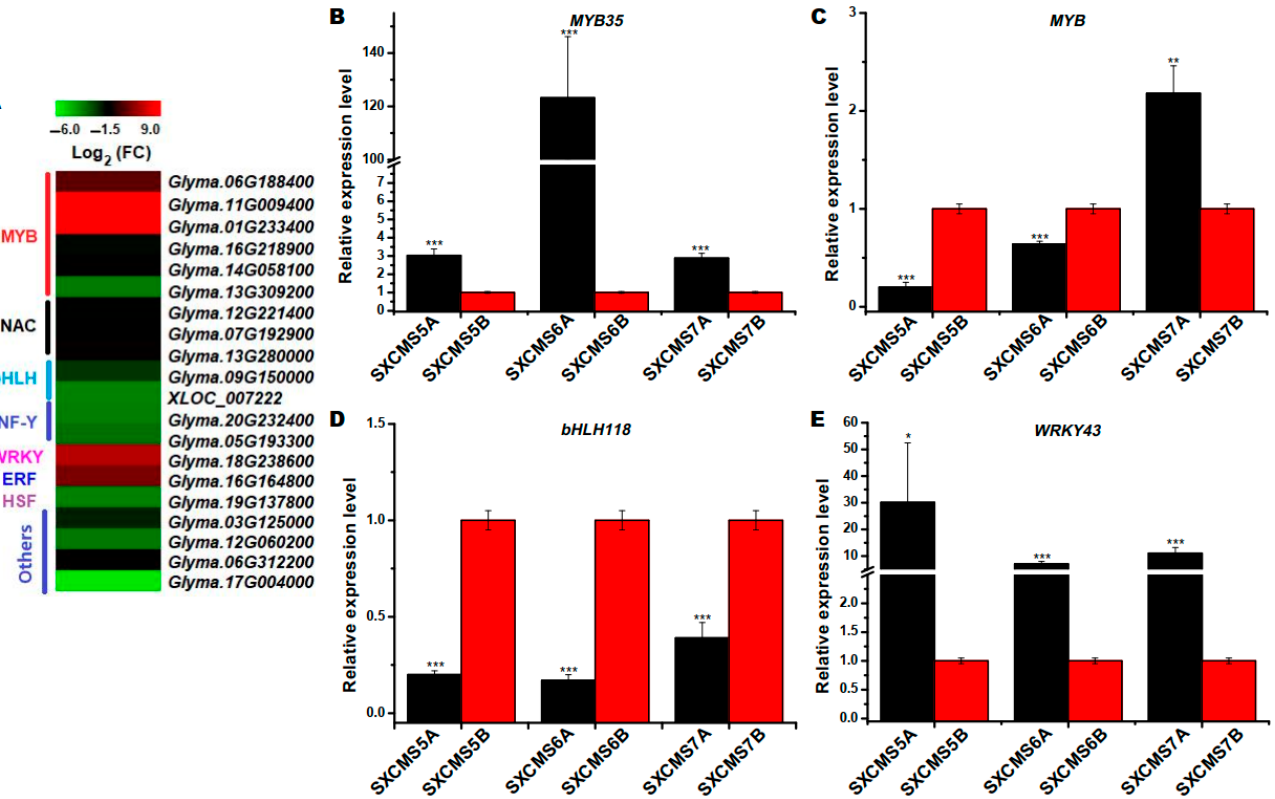
Figure 8. Analysis of DEGs related to transcription factors (TFs) between soybean CMS lines and their maintainers. ( A ) Heat map of the DEGs related to TFs between SXCMS5A and SXCMS5B. The heat map was created using MeV 4.9 software. Log 2 (FC) values were obtained from RNA-seq data. ( B – E ) Relative expression level of GmMYB35 ( Glyma.06G188400 ), GmMYB ( Glyma.16G218900 ), GmbHLH118 ( Glyma.09G150000 ) and GmWRKY43 ( Glyma.18G238600 ) between soybean CMS lines and their maintainers by qRT-PCR analysis. Asterisk indicated statistical significance: *, p < 0.05; **, p < 0.01; ***, p < 0.001.